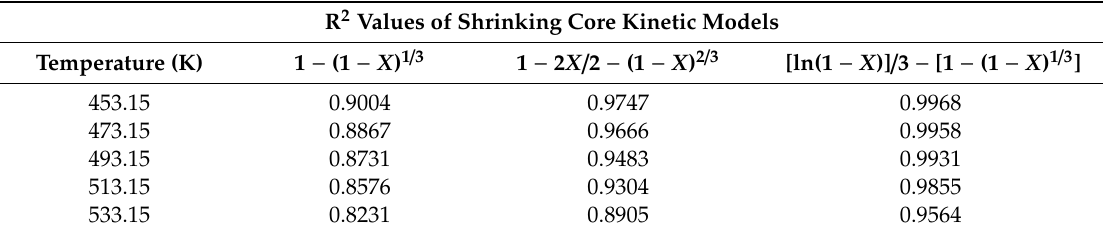
Table 2. R 2 values of shrinking core kinetic models for 2.5 h of leaching at di ff erent